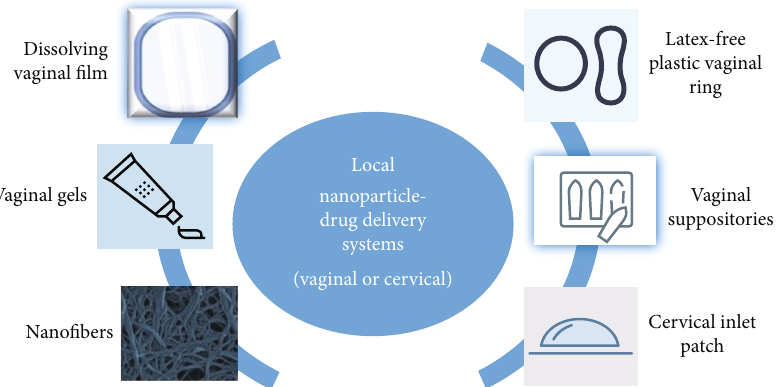
Figure 3: Localized drug delivery systems in cervical